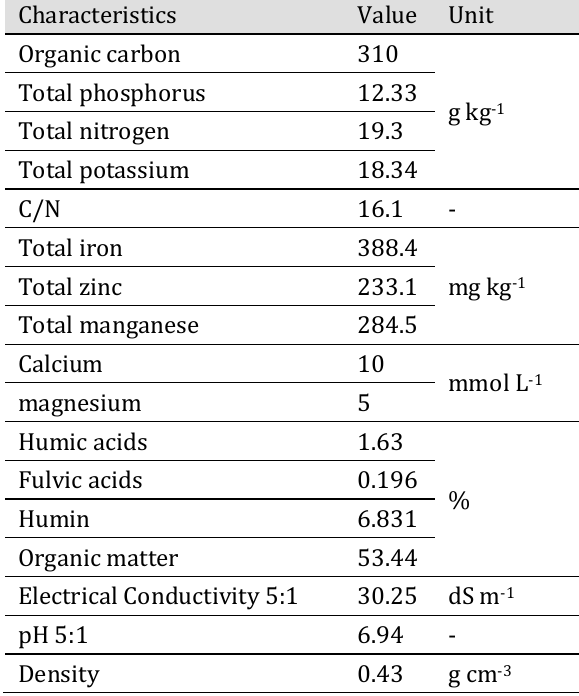
Table 2. The chemical a nd physical characteristics of the organic fertilizer mixture use d i n the